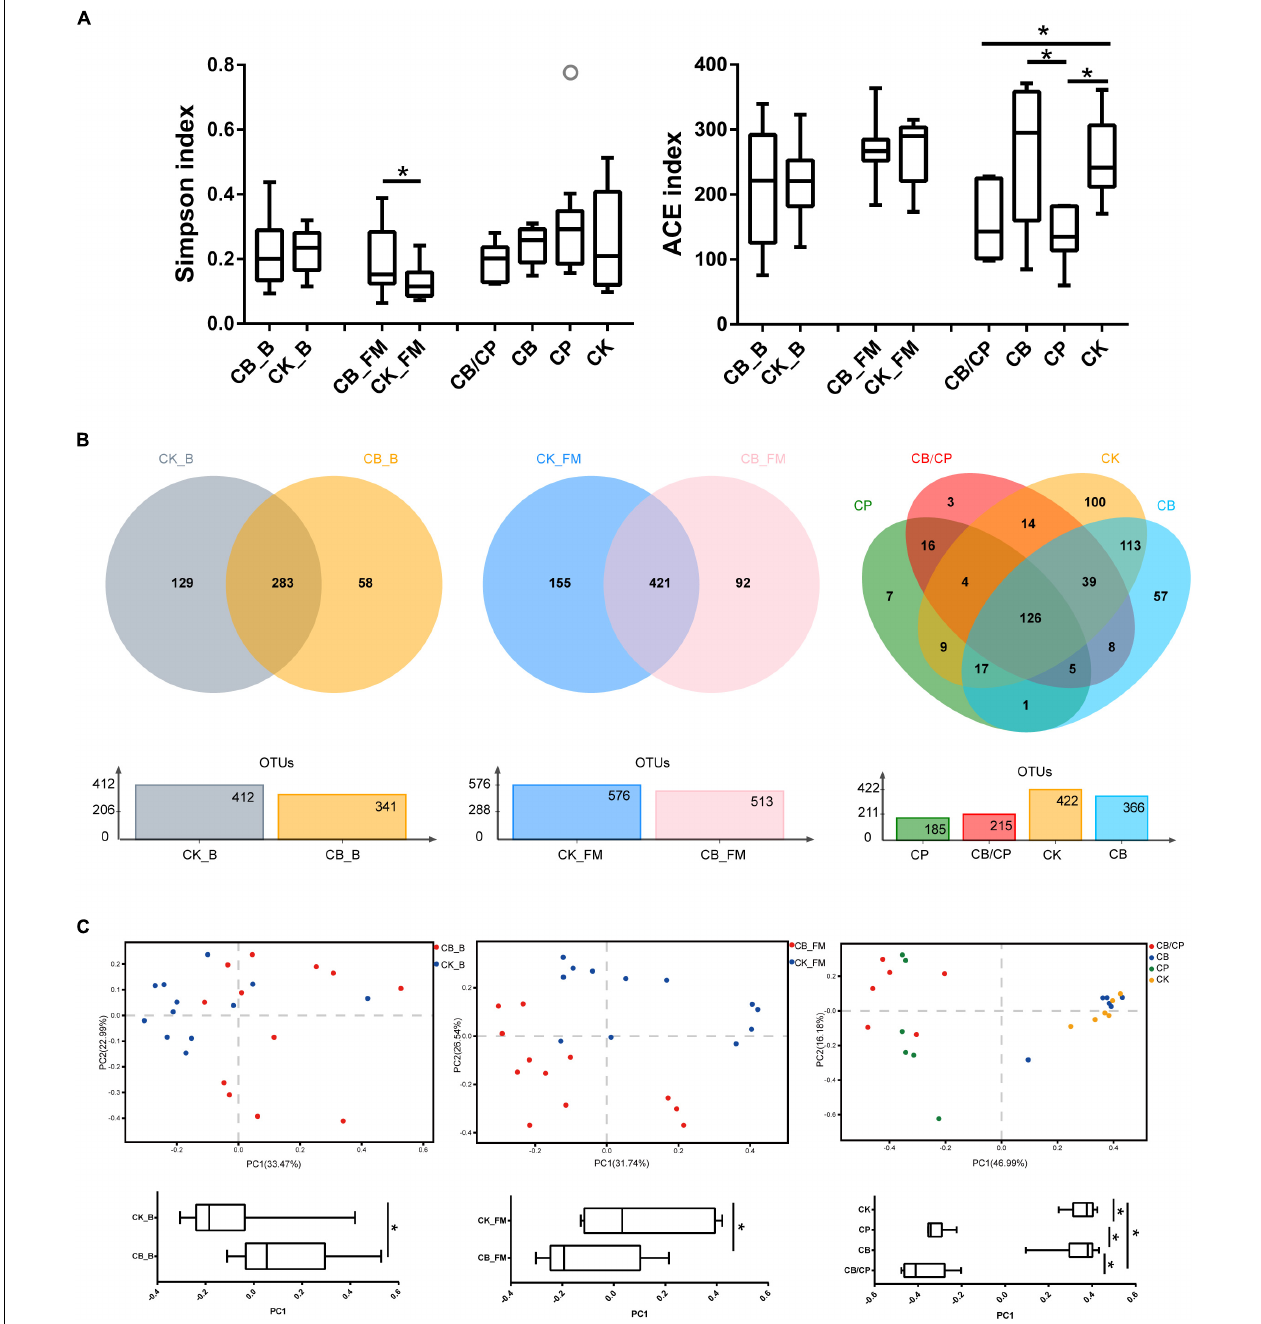
FIGURE 5 | Diversity of the intestinal bacteria community at different stages. (A) Alpha diversity was estimated using Simpson and ACE indices values. ∗ p < 0.05, measured using ANOVA. (B) Unique and shared intestinal OTUs shown in Venn diagrams. (C) PCoA plot of Bray-Curtis indices for the gut microbiota. PC1 comparisons were made using ANOVA. ∗ p < 0.05. CB_B, CK_B, CB_FM and CK_FM: n = 12; CB/CP, CB, CP and CK: n =